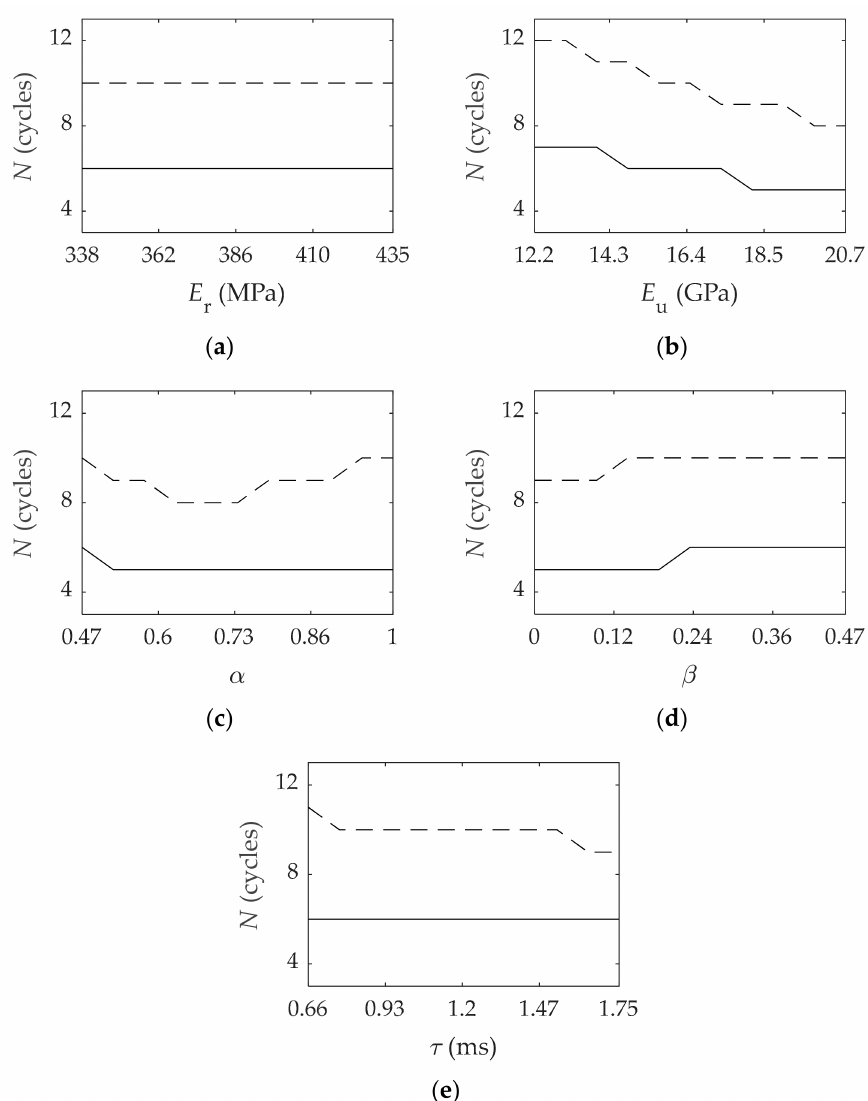
Figure 5. Viscoelastic material parameters influence on the number of cycles N for the asymmetrical ( ) and symmetrical